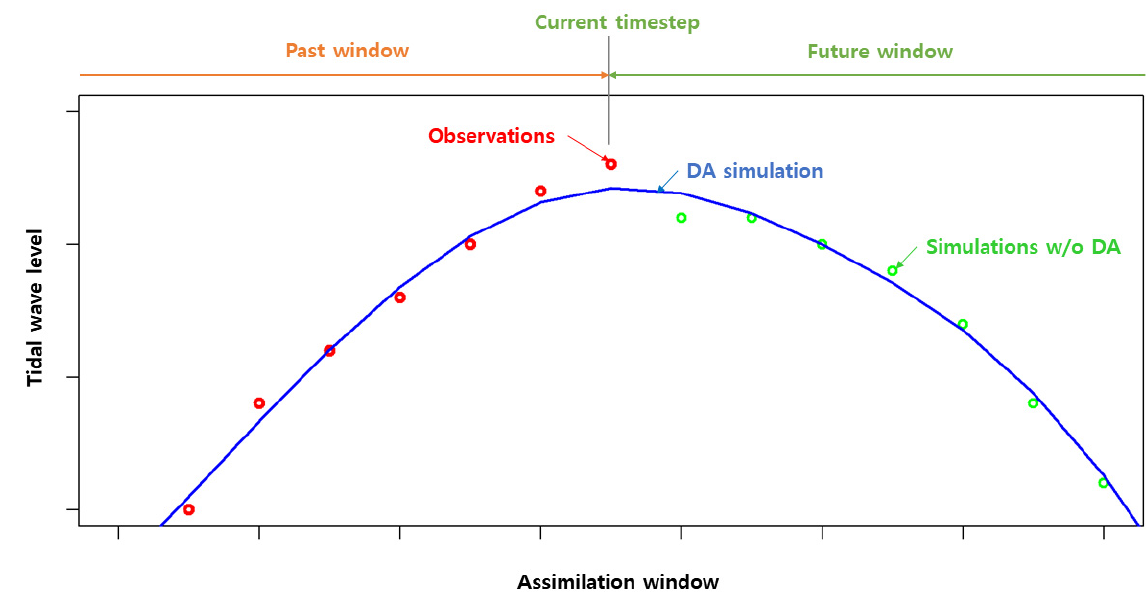
Figure 4. A schematic diagram of the DA method implemented via fixed-lag smoother.